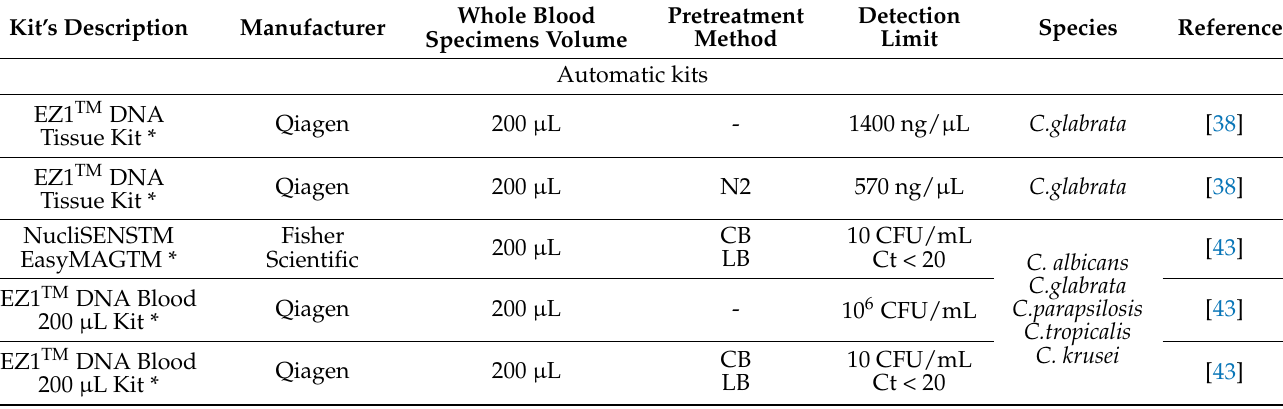
Table 2. Characteristics of the analyzed extraction kits on blood specimens and applied pretreatments as DNA extraction